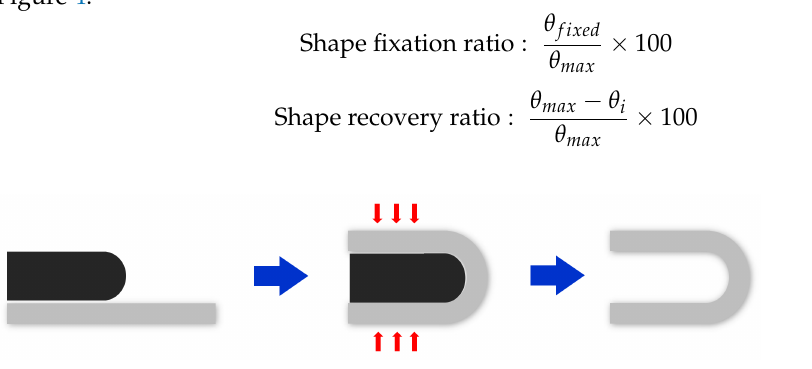
Figure 3. Process for the Test of Shape Fixation Properties.